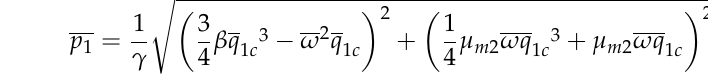
Table 1. The natural frequencies between 20–200 Hz of the cavity.